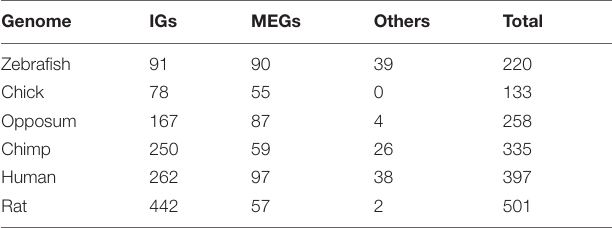
TABLE 1 | Summary of mouse IG orthologs in selected genomes.